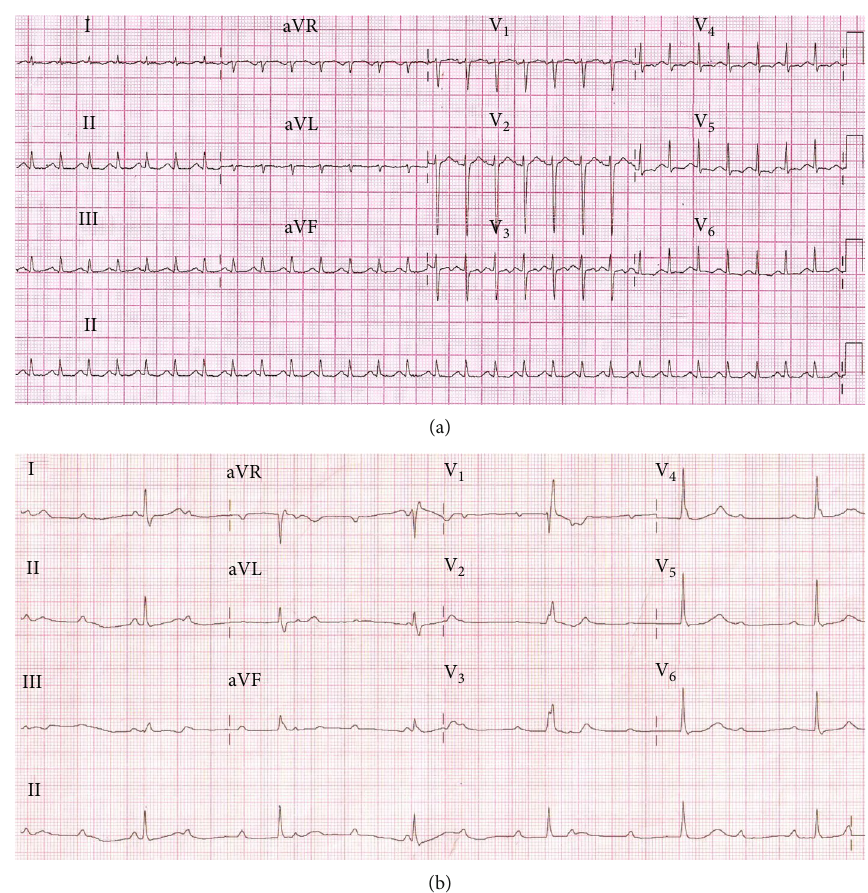
Figure 3: (a) ECG on admission for patient 3 showing sinus tachycardia. (b) ECG for patient 3 on day 5 admission showing complete heart block CHB with narrow QRS, suggesting distal AV node focus as origin of escape